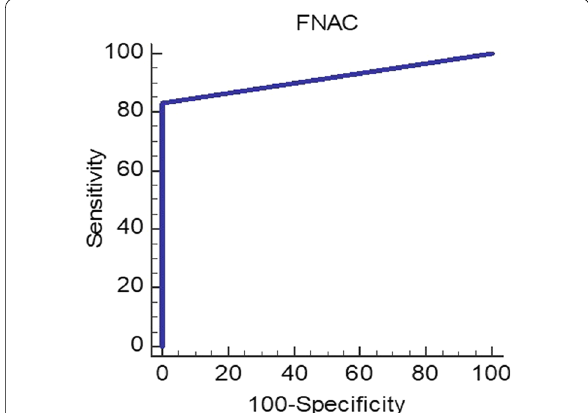
Fig. 3 ROC curve for the accuracy of FNAC in identifying malignant axillary lymph nodes